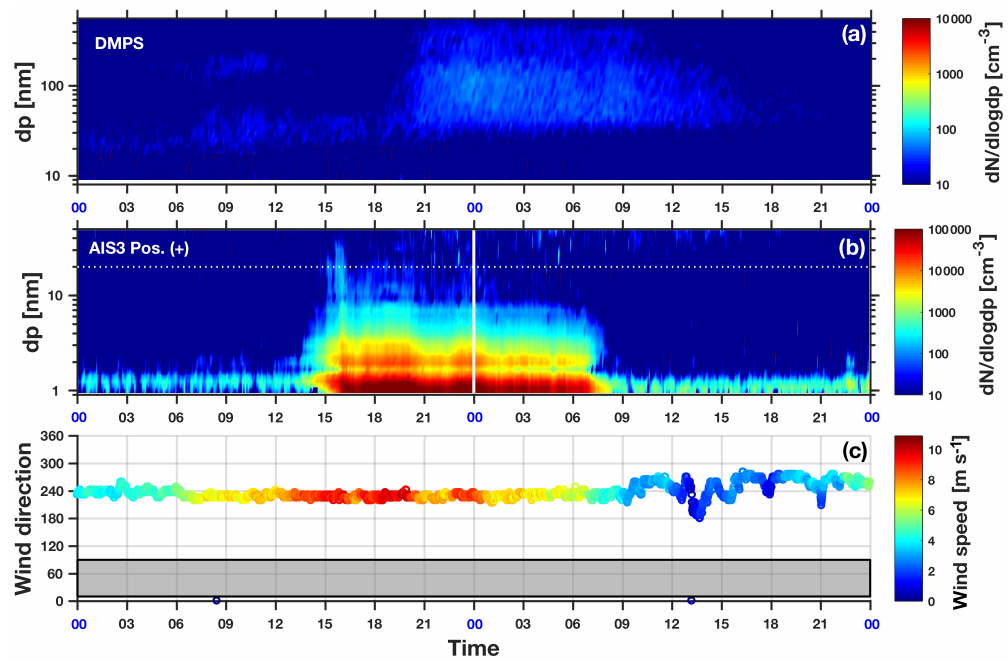
Figure 8. A wind-induced ion formation event observed on 3–4 July 2011. (a) DMPS spectra; (b) AIS positive polarity spectra; and (c) wind direction, colour-coded with wind speed. The white dotted line is a visual guide to outline the 20nm location. The grey band in (c) represents the contaminated wind sector. Data are presented in